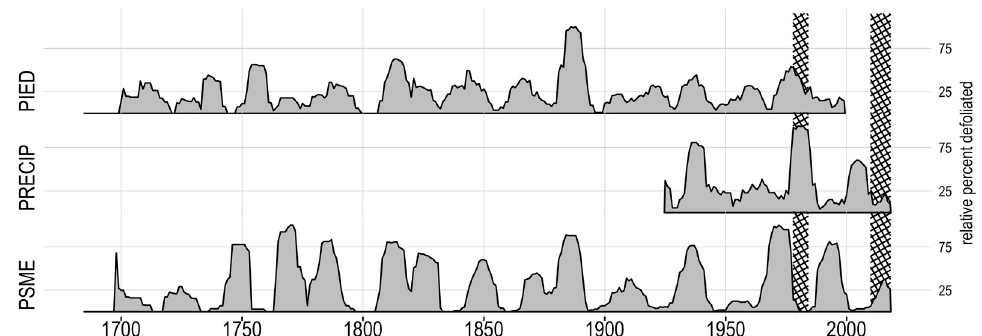
Figure 3. Effect of using different non-host inputs, represented by percent of defoliation of host tree series: pinyon pine chronology AZ129 (PIED), annual instrumental precipitation (PRECIP), and the combined Douglas-fir chronologies used for this study (PSME). Crosshatched regions are observed outbreak periods. The 1978–1984 outbreak is evident in the precipitation and PIED non-host but masked in the PSME results.